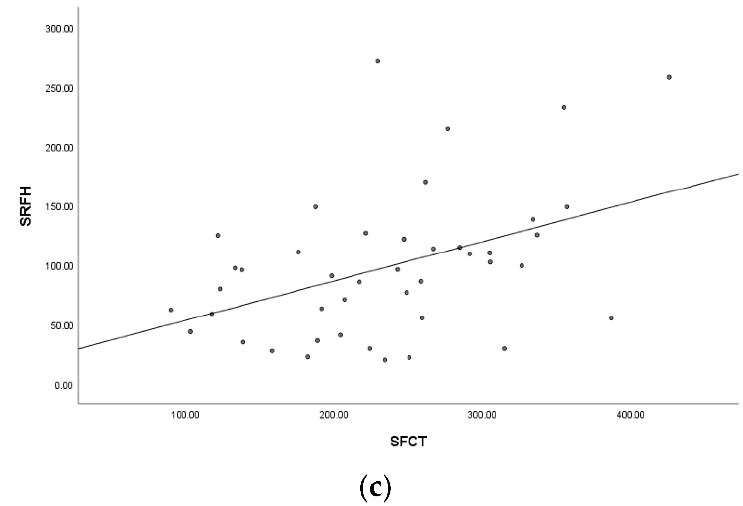
Figure 3. The scatterplots show the relationship between subretinal fluid height (SRFH) and subfoveal choroidal thickness (SFCT). ( a ): There is a weak positive correlation between SRFH and SFCT (r s = 0.275, p = 0.002). ( b ): In the high myopia group, SRFH has no significant relationship with SFCT ( p = 0.064). ( c ): In the non-high myopia group, SRFH is moderately positively correlated with SFCT (r s = 0.402, p = 0.008).